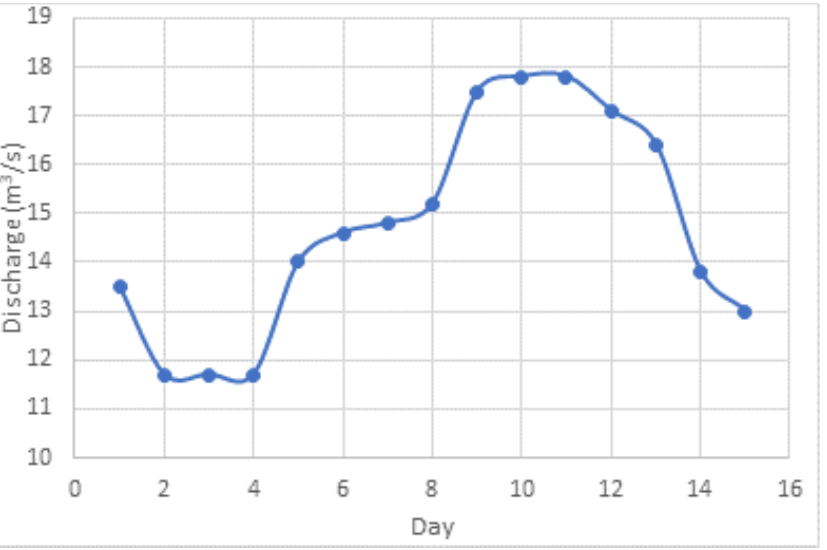
Figure 2. The flow hydrograph for an upstream section shows the time range of the maximum flow during the observed flood in September